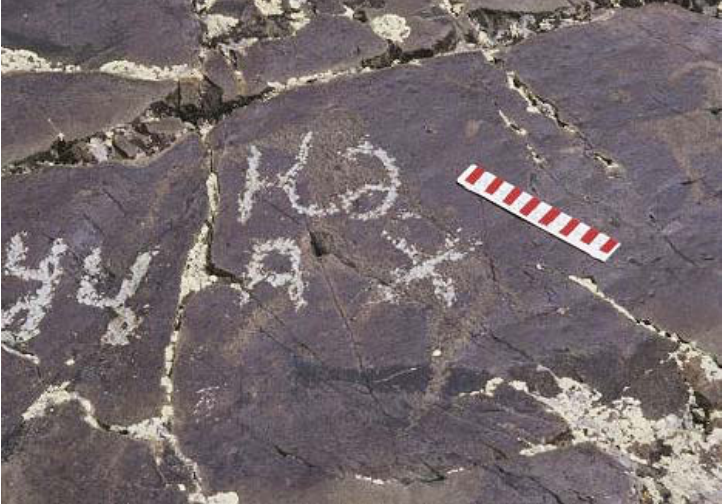
Figure 16. Mammoth overlaid by contemporary writing. Paleolithic period. Baga